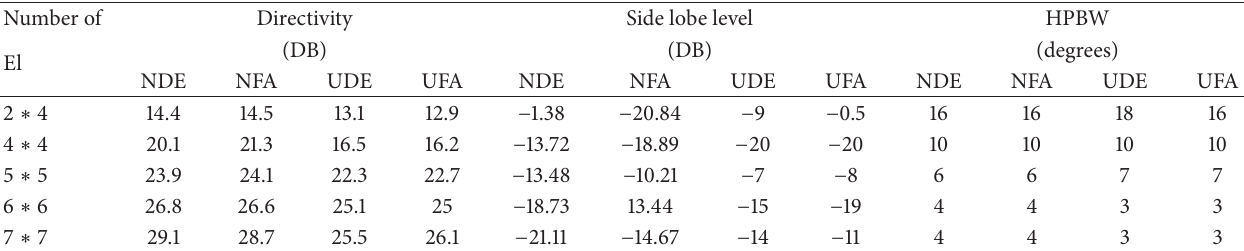
Table 1: Statistical antenna array performance data of hemispherical nonuniform